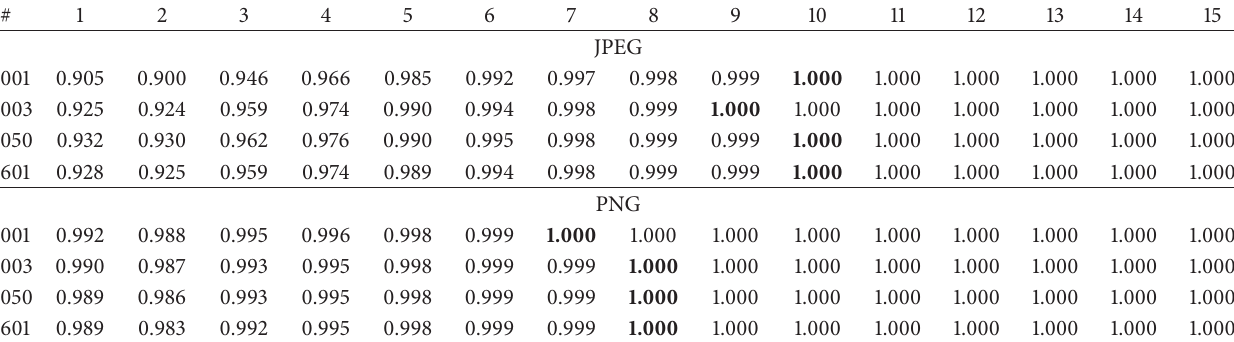
Table 7: SSIM results of proposed watermarking method.